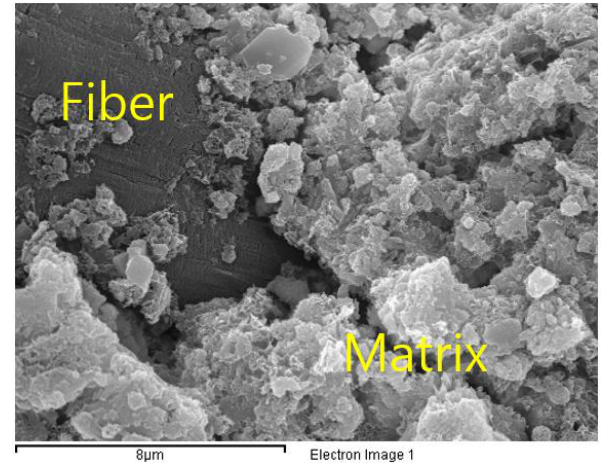
Figure 6. SEM images of composite.